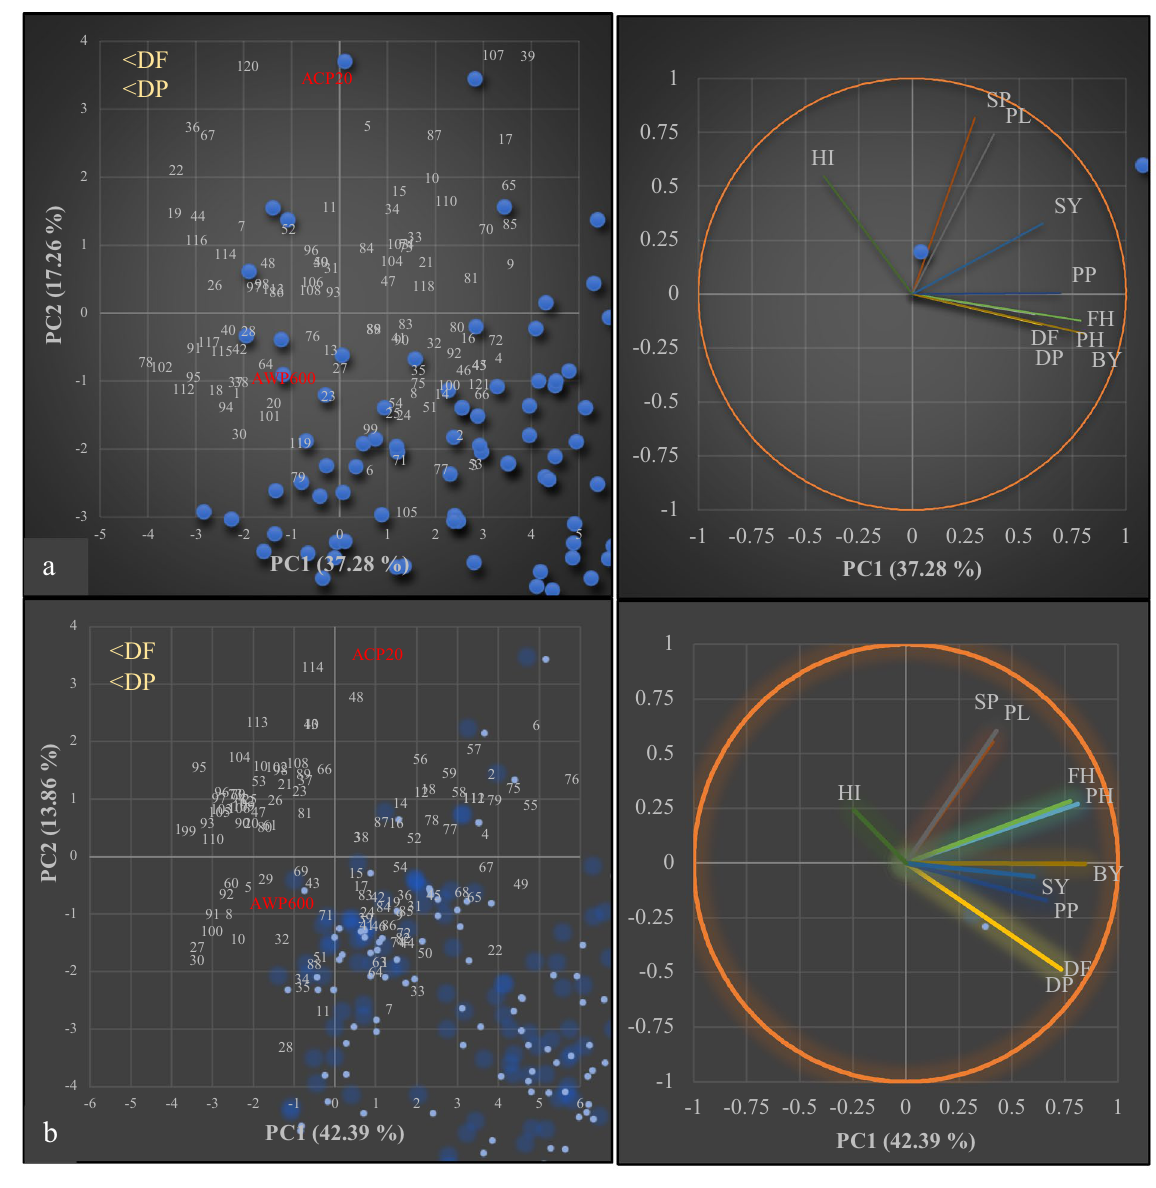
Figure 5. Principal component analyses (PCAs) for in F 2 ( a ) and F 3 ( b ) populations derived from interspecific crosses P. sativum × P. fulvum . Each blue dot represents a progeny in F 2 and F 3 populations. (DF is days to flowering, DP is days to pod setting, PH is plant height, FH is first pod height, PP is number of pods per plant, SP is number of seeds per plant, PL is pod length, BY is biological yield, SY is seed yield, HI is harvest